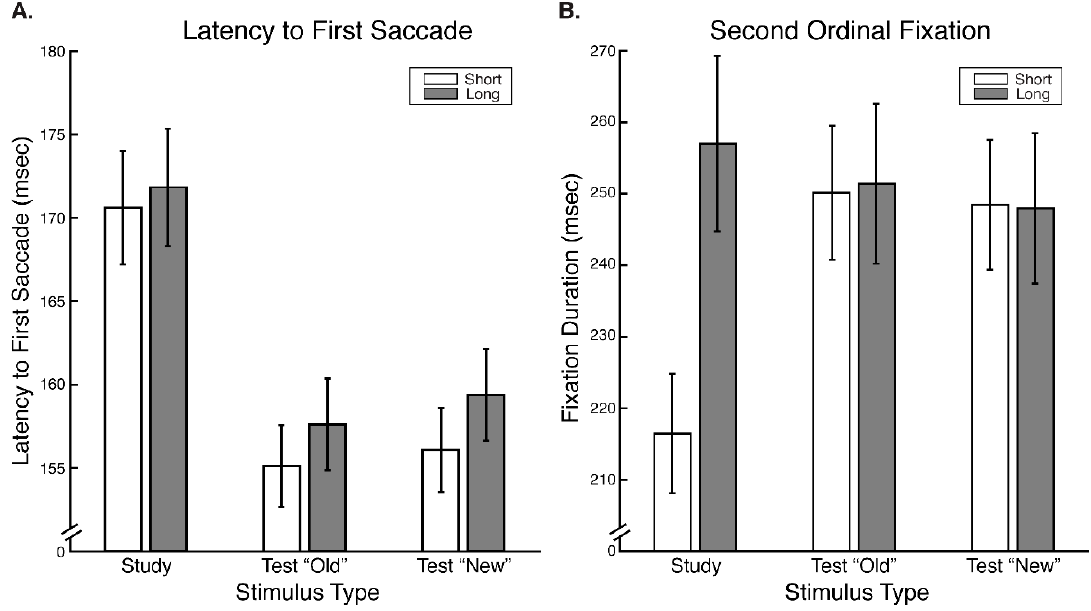
Figure 4. Temporal dynamics of eye-movements. ( A ) Latency to first saccade and ( B ) fixation durations for the second ordinal fixation. Each is plotted by stimulus experience type (Study, “old” test face, “new” test face) and stimulus presentation time condition (white bars = “short” one second, gray bars = “long” five seconds). Latency to first saccade was longer ( p < 0.0005) during the study than the test phase. Fixation duration for the second ordinal fixation was shorter ( p < 0.005) for the short study phase condition than for other conditions.